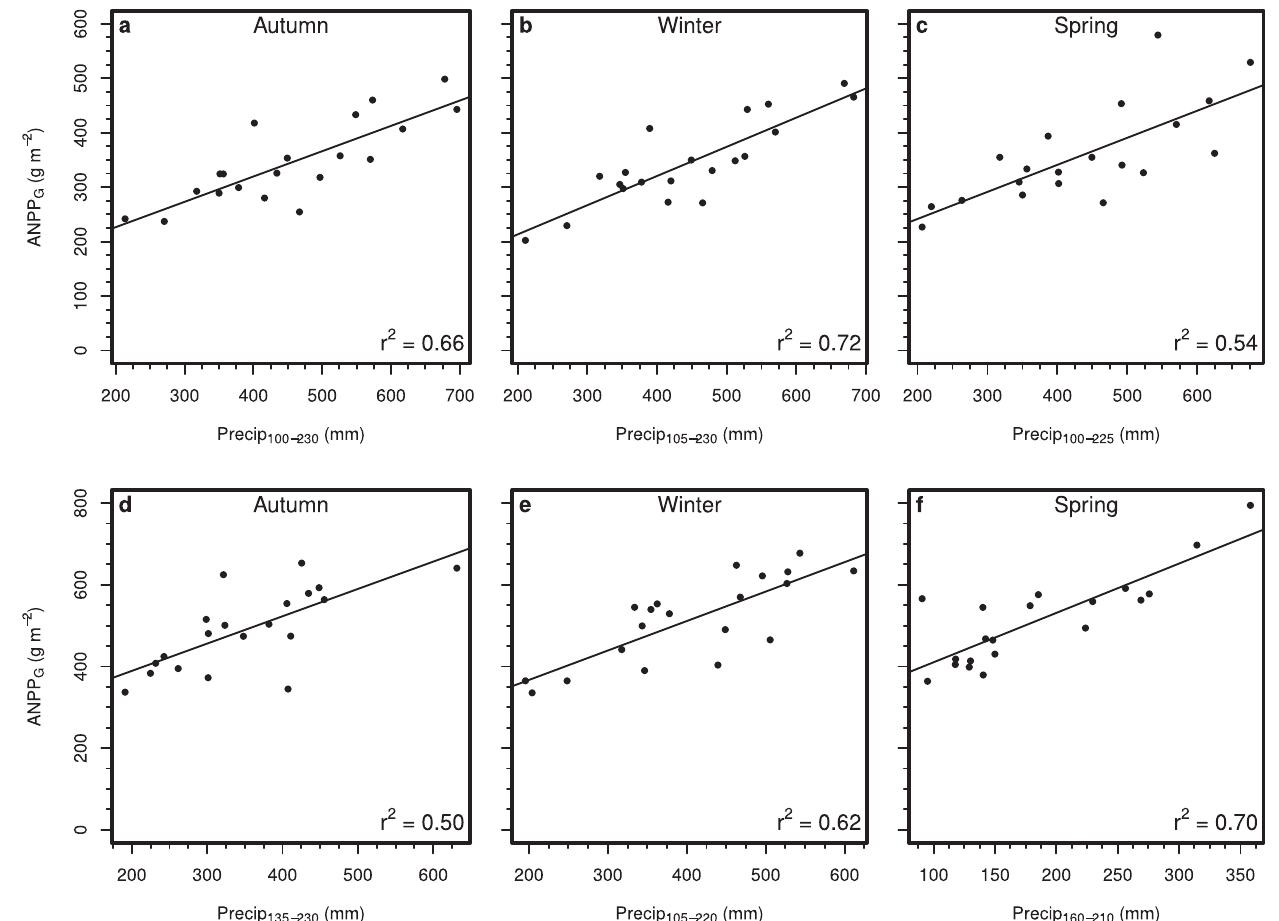
Figure 3. Relationships between precipitation during critical precipitation period and grass productivity (ANPP G ) for uplands (a–c) and lowlands (d–f) for autumn (a,d), winter (b,e), and spring-burned (c,f) watersheds.